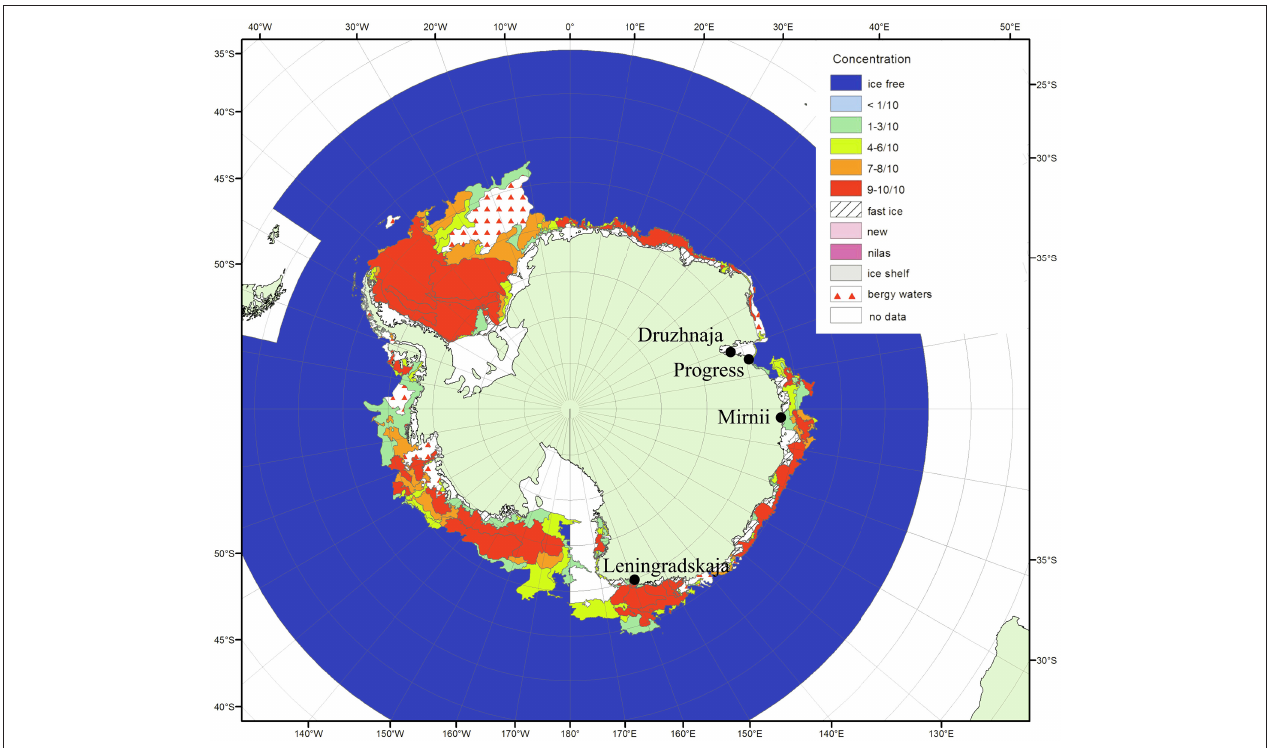
FIGURE 1 | Antarctic surface snow sampling sites. The locations of the four Russian research stations where the snow samples were taken are shown on the map of Antarctica (from the archive of Russian Institute of Arctic and Antarctica http://wdc.aari.ru/datasets/d0040/antarc/png/). The color code indicates ice concentration for January 2010 during the time of sampling. The distances from open water for Mirnii and Progress are 1–5 km, for Druzhnaja—150km, for Leningradskaja—400km.